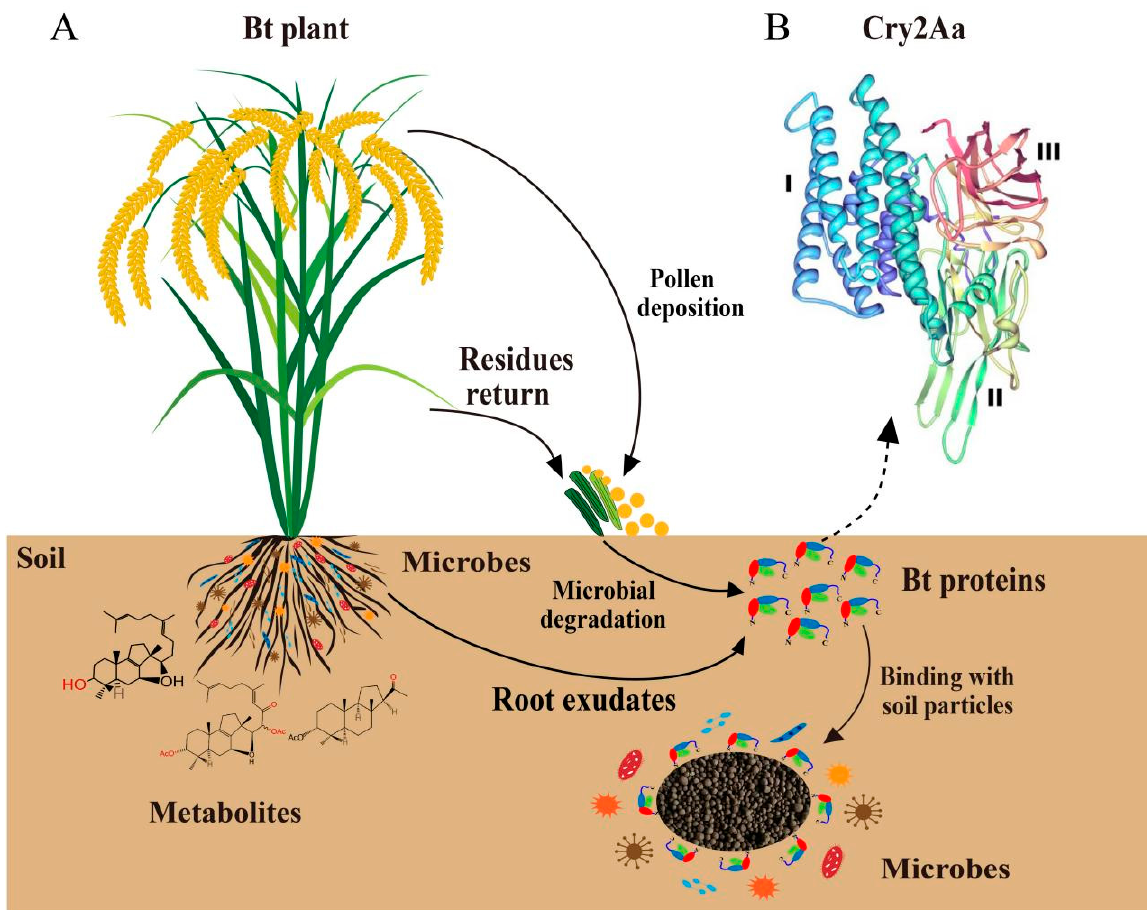
Figure 1. Environmental behaviors of Bt protein ( A ) and its three-dimensional structures ( B ). I, II, and III: domains I, II, and III.